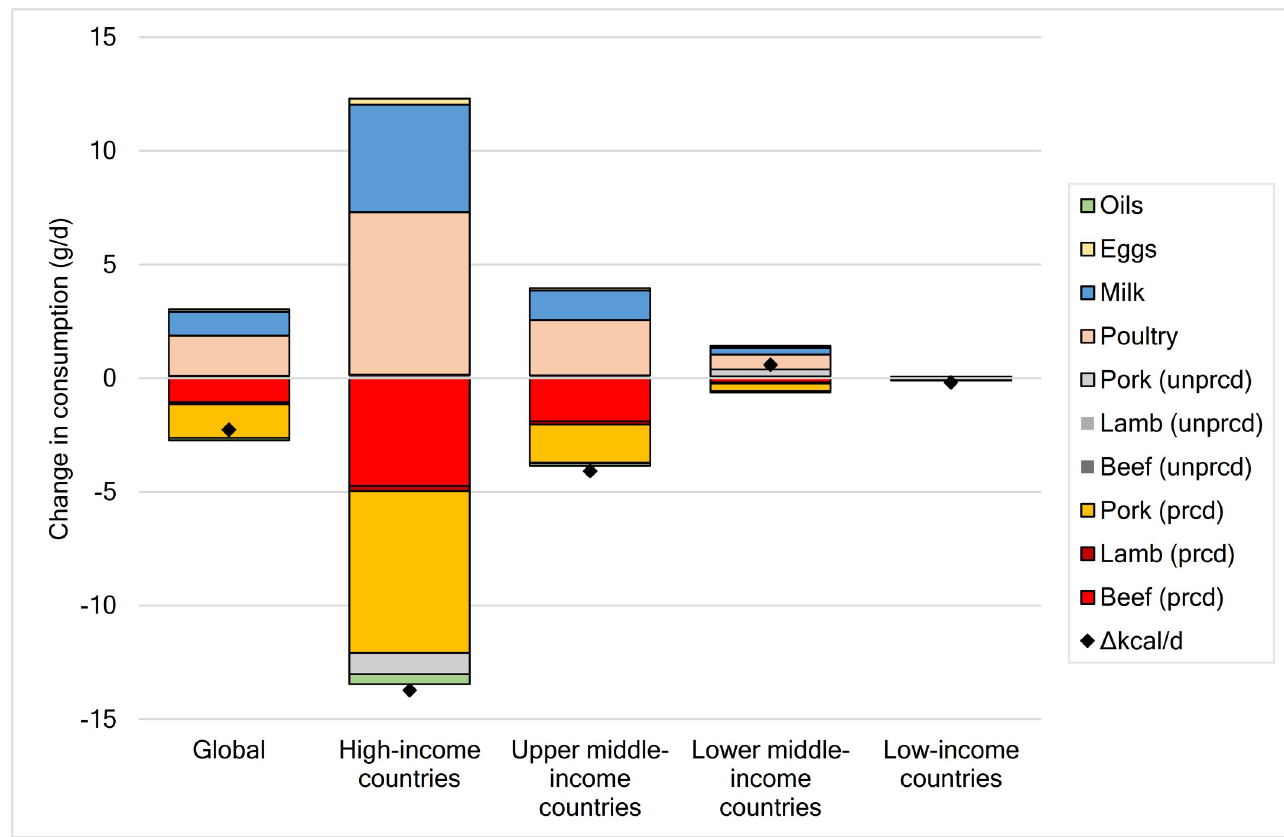
Fig 3. Tax-related changes in food consumption by food commodity and region. Food commodities include processed (prcd) and unprocessed (unprcd) red meats. Changes in food consumption are shown in g/d, with the exception of Δ kcal/d which denotes changes in overall energy intake in terms of kcal/d.